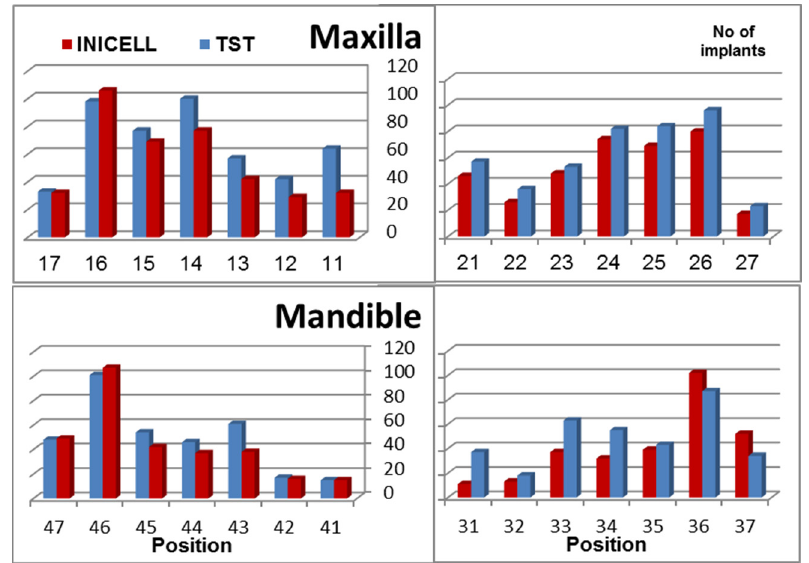
Figure 2. Number of INICELL and TST implants shown on the vertical axis is split by position in both jaws.